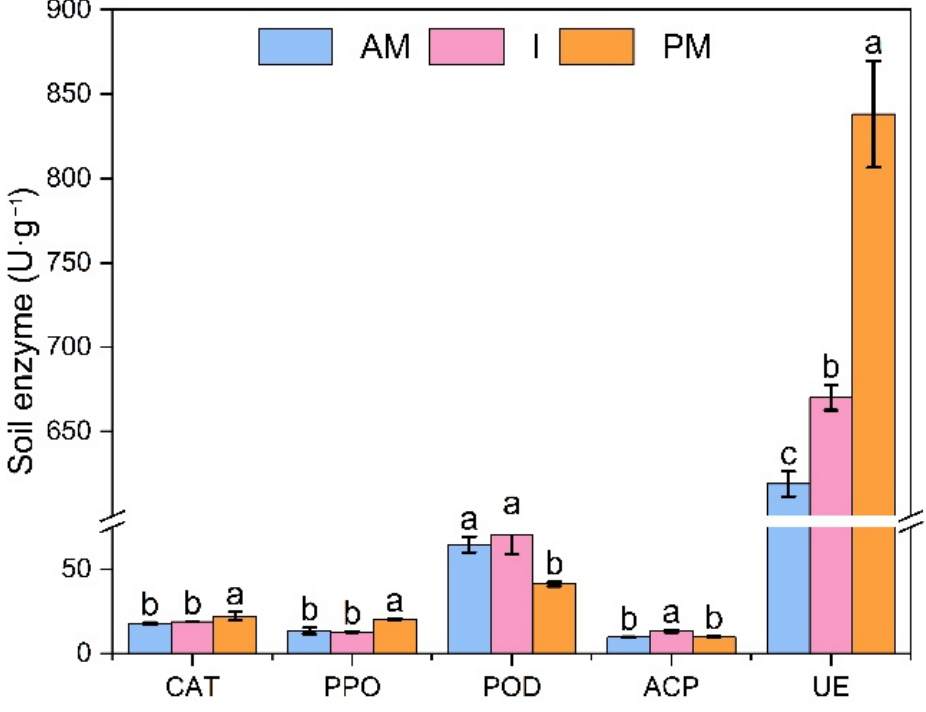
Figure 2. Soil enzyme activity under different cropping patterns. Different letters indicate significant differences (ANOVA, p < 0.05, and Tukey’s HSD post hoc analysis) among different planting modes. AM represents areca nut monocropping; I represents areca nut intercropping with pandan; and PM represents pandan monocropping. Different lowercase letters indicate significant differences between treatments under the same index ( p <